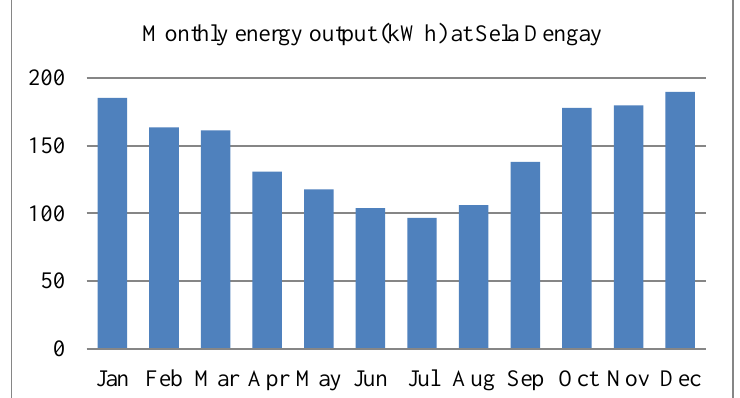
Figure 11. Energy assessment of solar system at Sela Dengay.